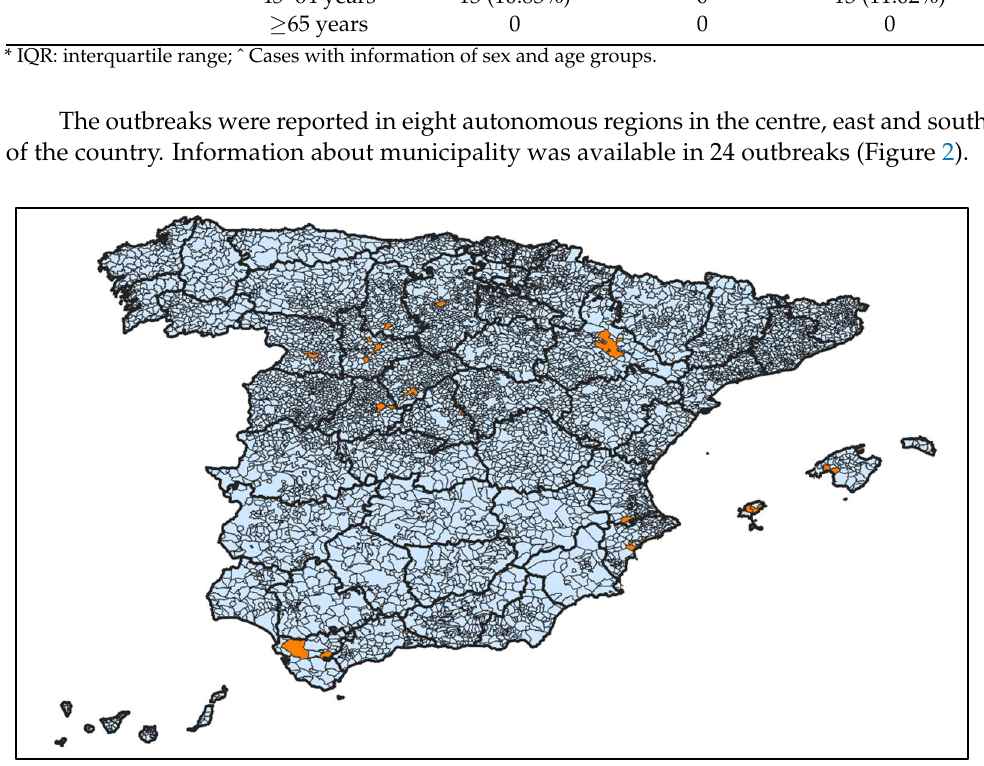
Figure 3. Cumulative incidence (CI) and male-to-female ratio, 2012–2019. Temporal trends were also studied by sex and age groups. In women, an inversely proportional association was observed between cumulative incidence and age, with the 0–14 years-old group having the greatest one during the entire period, with 5.97 cases per 100,000 inhabitants in 2018. Nevertheless, in addition to the youngest population, a con- siderable increase of cases was observed in women aged 15–64 in 2017 and 2018. Regard- ing men, the inversely proportional association previously described was observed until 2015, with 3.92 cases per 100,000 inhabitants in the 0–14 years-old group that year. Since